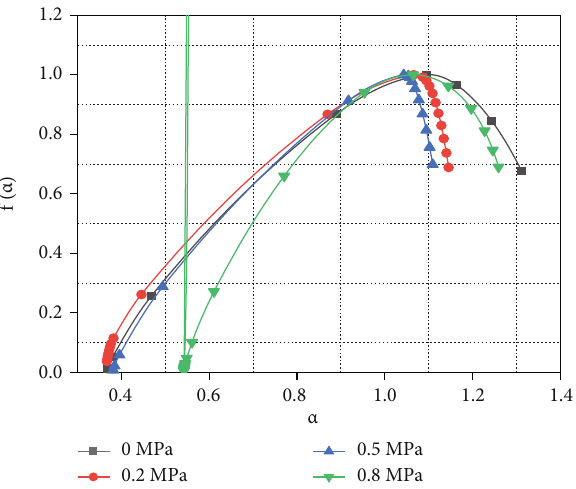
Figure 8: Multifractal spectra of di ff erent gas pressure.